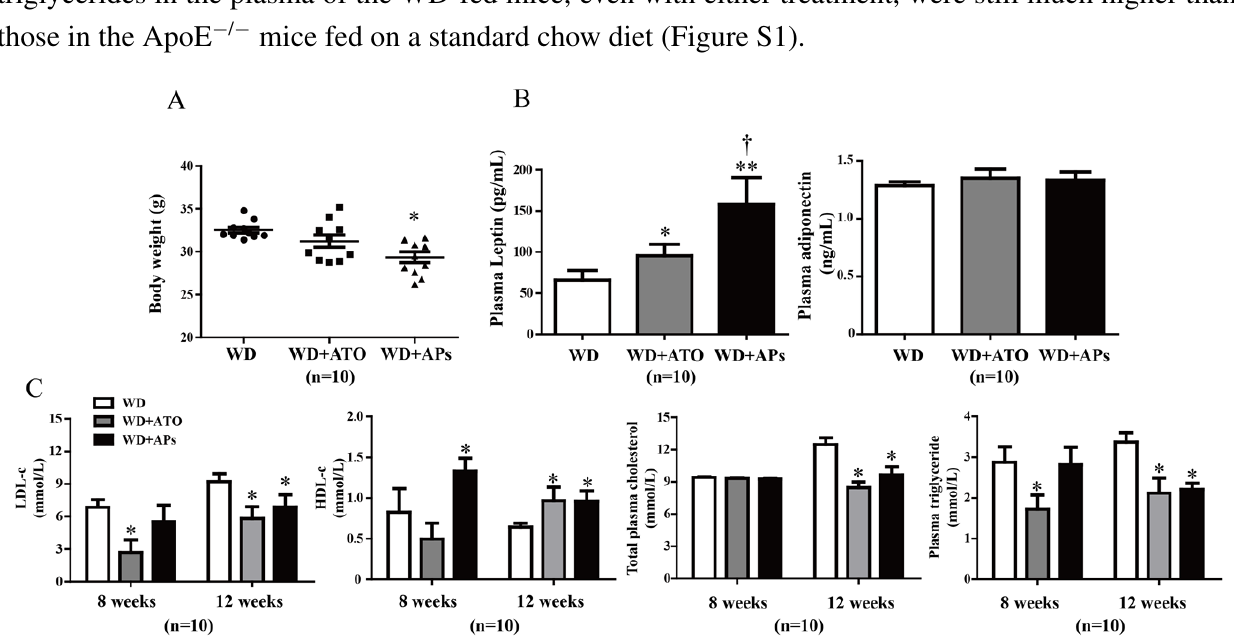
Figure 2. The APs treatment normalized the up-regulated body weight and metabolic parameters in the WD-fed ApoE −/− mice. A : Assessment of body weight for the weeks 12; B : Concentrations of leptin and adiponectin in plasma; C : Total cholesterol, triglycerides, LDL-c, and HDL-c were quantified by enzymatic assays. The values are presented as the means ± S.E.M, n = 10 per group. * p < 0.05, ** p < 0.01, *** p < 0.001 vs. WD mice; † p < 0.05 vs. WD + ATO mice.